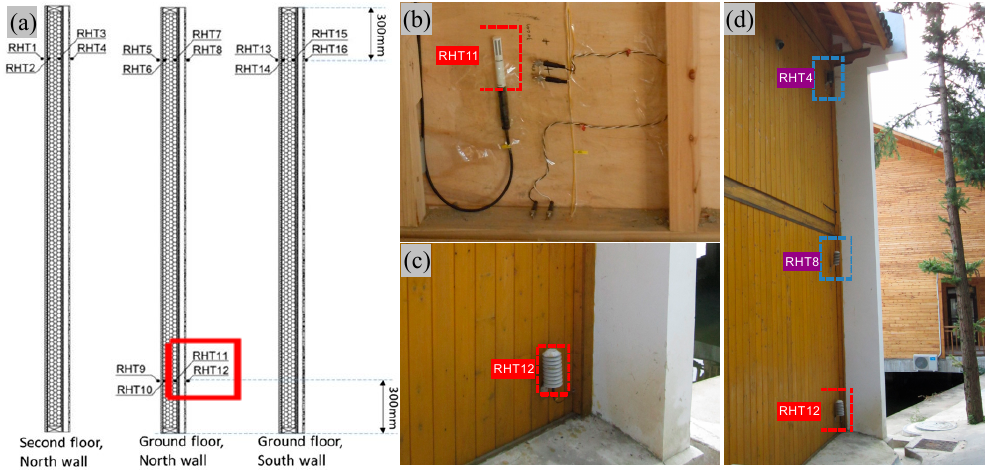
Figure 2. The sensor layout of ( a ) 2.8m high wall section; ( b ) RHT11; ( c ) RHT12; ( d ) the outside of the